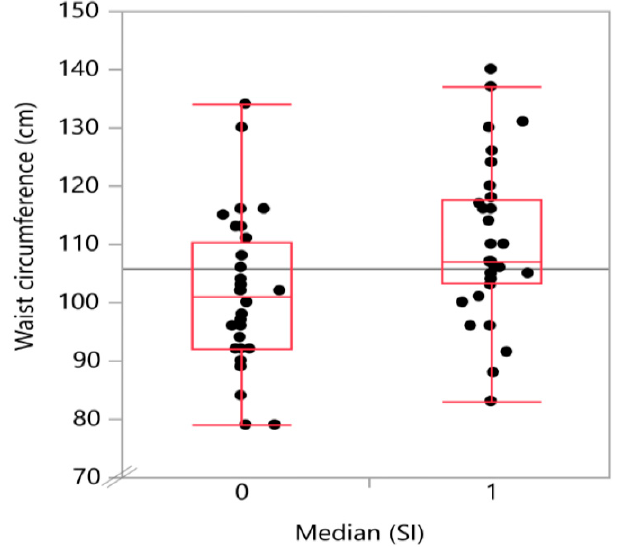
Figure 3. Boxplot with the distribution of waist circumference by snoring index groups. A higher snoring index was associated with a higher waist circumference.